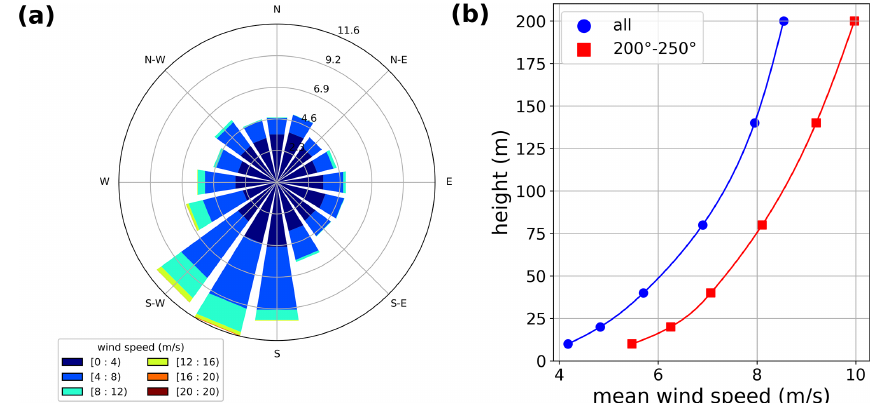
Figure 2. Wind conditions during the measurement campaign (15 February 2018 until 29 February 2020): (a) wind rose at 10m height, (b) wind speed profiles for all wind directions and the wind sector between 200 and 250 ◦ . All are based on mast wind measurements.